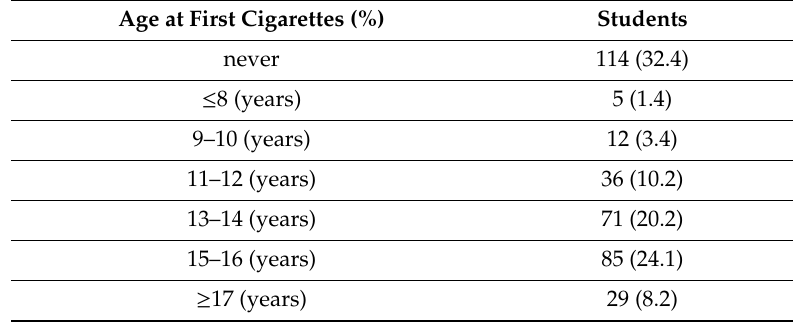
Table 2. Percentage of students divided by the di ff erent age of their first cigarette.